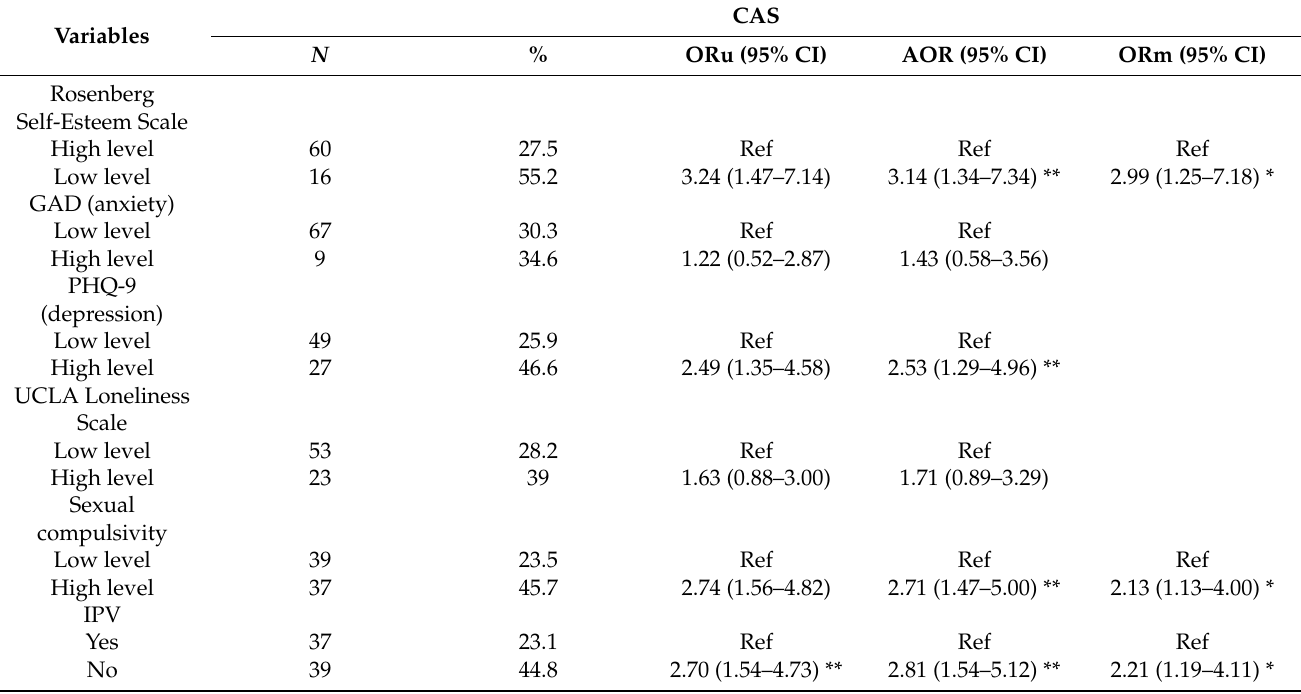
Table 4. Association between psychosocial variables and CAS among transgender women ( N =